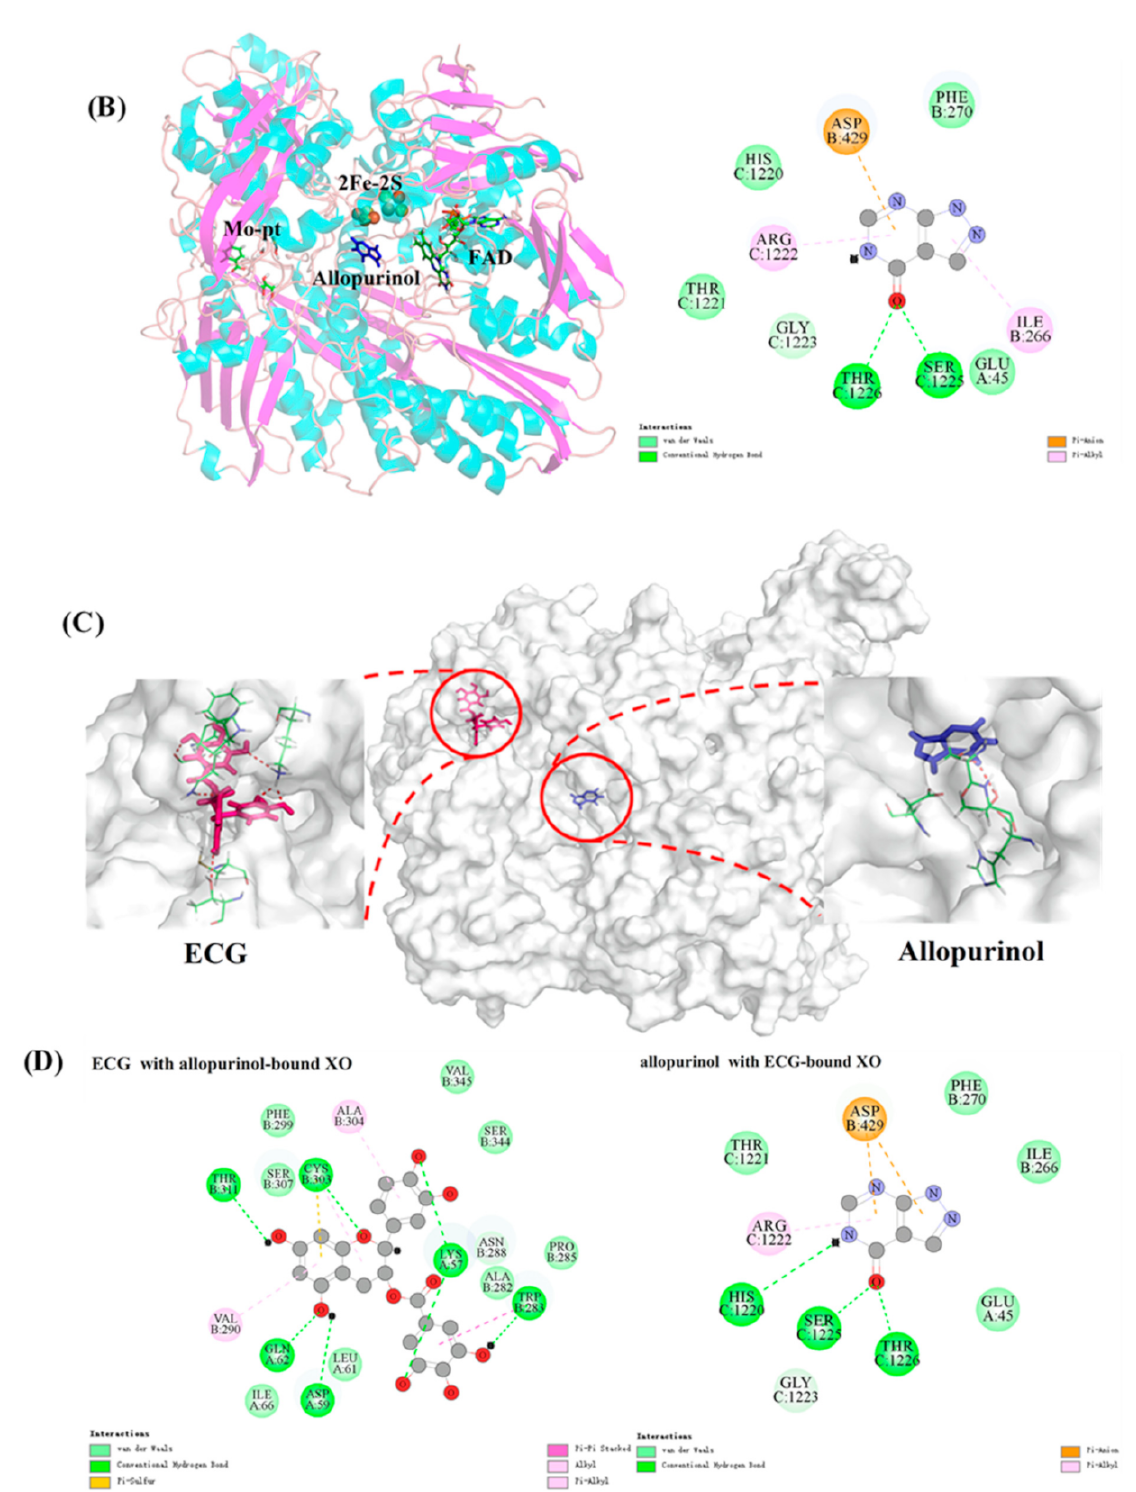
Figure 7. Molecular docking analysis of synergistic inhibition. ( A ) Isoboles of additivity for the combination of ECG and allopurinol at 30%, 50%, and 70% inhibition levels; ( B ) the docking model and 2D schematic diagram of allopurinol–XO complex; ( C ) the 3D interaction pattern of ECG and allopurinol with XO; ( D ) the 2D schematic diagrams of ECG interacting with XO in the presence of allopurinol, and allopurinol interacting with XO in the presence of